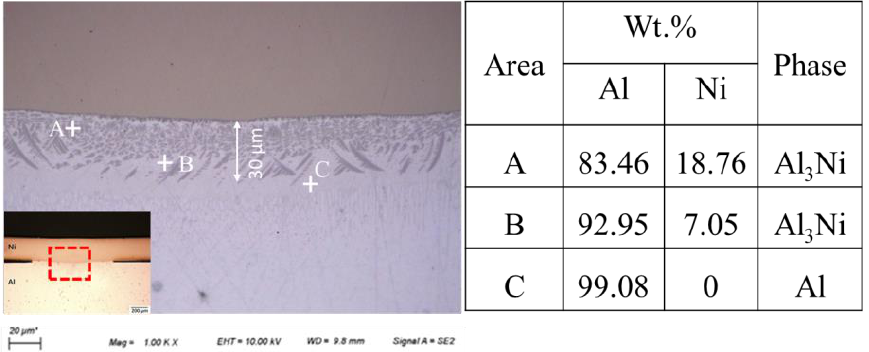
Figure 8. SEM image with high magnification, EDS results in areas A – D of the Al – Ni joint welded using CW laser with 1800 W laser power at focal point position of +5mm.